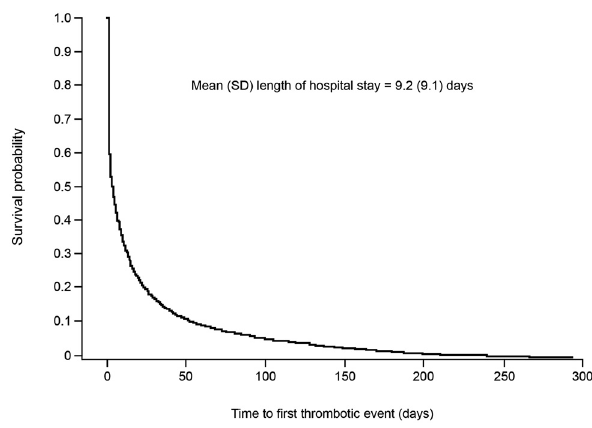
Fig. 3 Time to fi rst thromboembolic event. The median (interquartile range) for thromboembolic events to accrue was 4 (1, 17) days, and the probability of having the fi rst thromboembolic event at day 9 (mean duration of hospital stay) was 35.9%. SD, standard